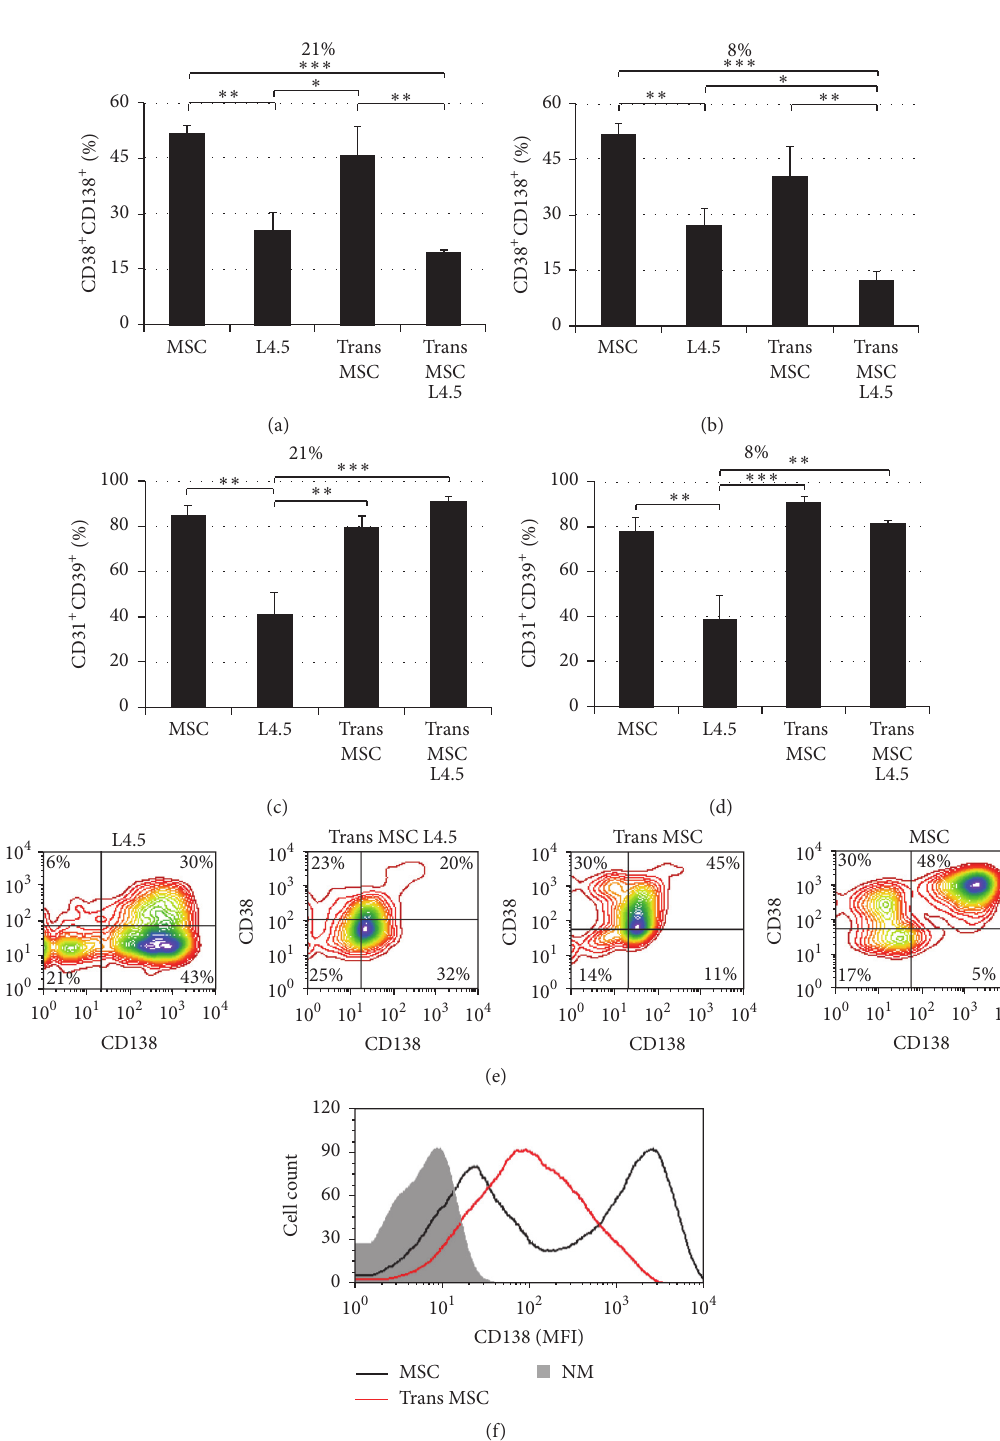
Figure 4: Mesenchymal stem cells influence plasma cell formation with or without cellular contact. Five independent samples of switched memory B lymphocytes were cultured as described in Figure 2(a) for the expansion and transition phases. For the differentiation phase, cells were grown in the presence of L4.5 cells, with or without MSC, which were added either in direct contact or in the upper chambers of a transwell. All assays were done in parallel for all conditions and at 21% and 8% O 2 . The same gating strategy was used as described in Figure 3. (a) and (b) Frequencies of CD38 + CD138 + populations as observed following culture at 21% and 8% O 2 , respectively. (c) and (d) Frequencies of CD31 + CD39 + populations as observed following culture at 21% and 8% O 2 , respectively. (e) A representative profile of CD38 and CD138 expression at the end of the differentiation step for each condition tested at 21% O 2 is shown. (f) CD138 expression on cells following cultures with MSC in transwell (red line) and in direct contact (gray line), compared to unlabeled cells (shaded). Statistical analyses were done using a Dunn multiple comparison 𝑡 -test, and 𝑝 values are shown as indicated; ∗ 𝑝 ≤ 0.05 , ∗∗ 𝑝 ≤ 0.01 , and ∗∗∗ 𝑝 ≤ 0.001 . Data are presented as means ±